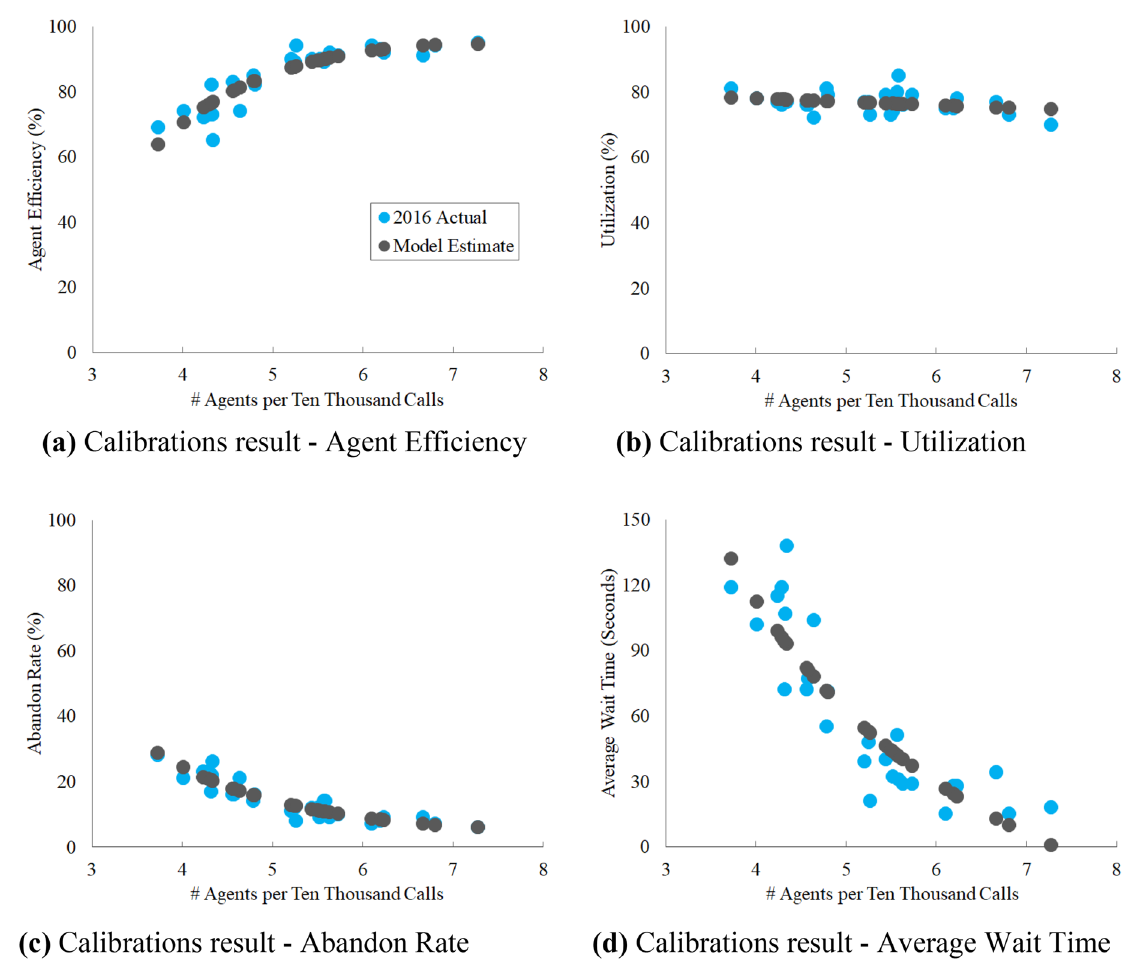
Fig. 1 Model calibration results based on Chicago 311 contact center’s 2016